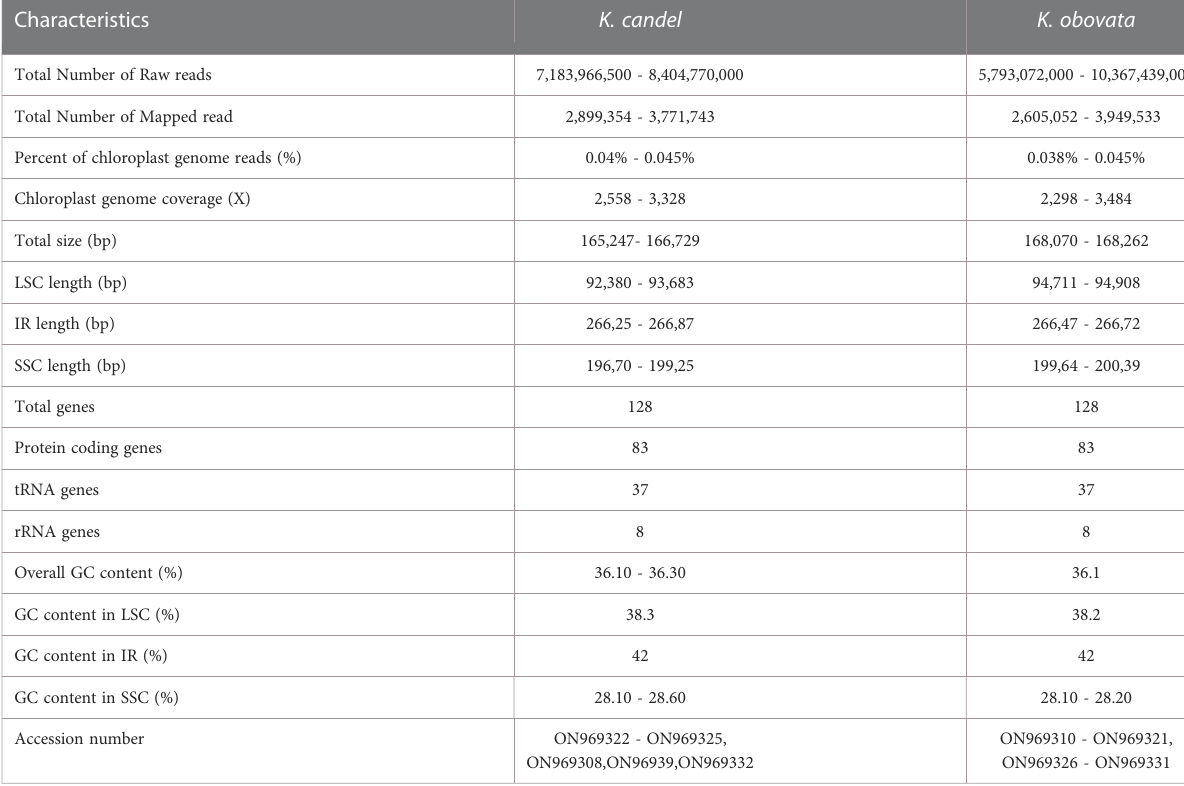
TABLE 1 The basic chloroplast genome information of the 25 Kandelia accessions. Characteristics